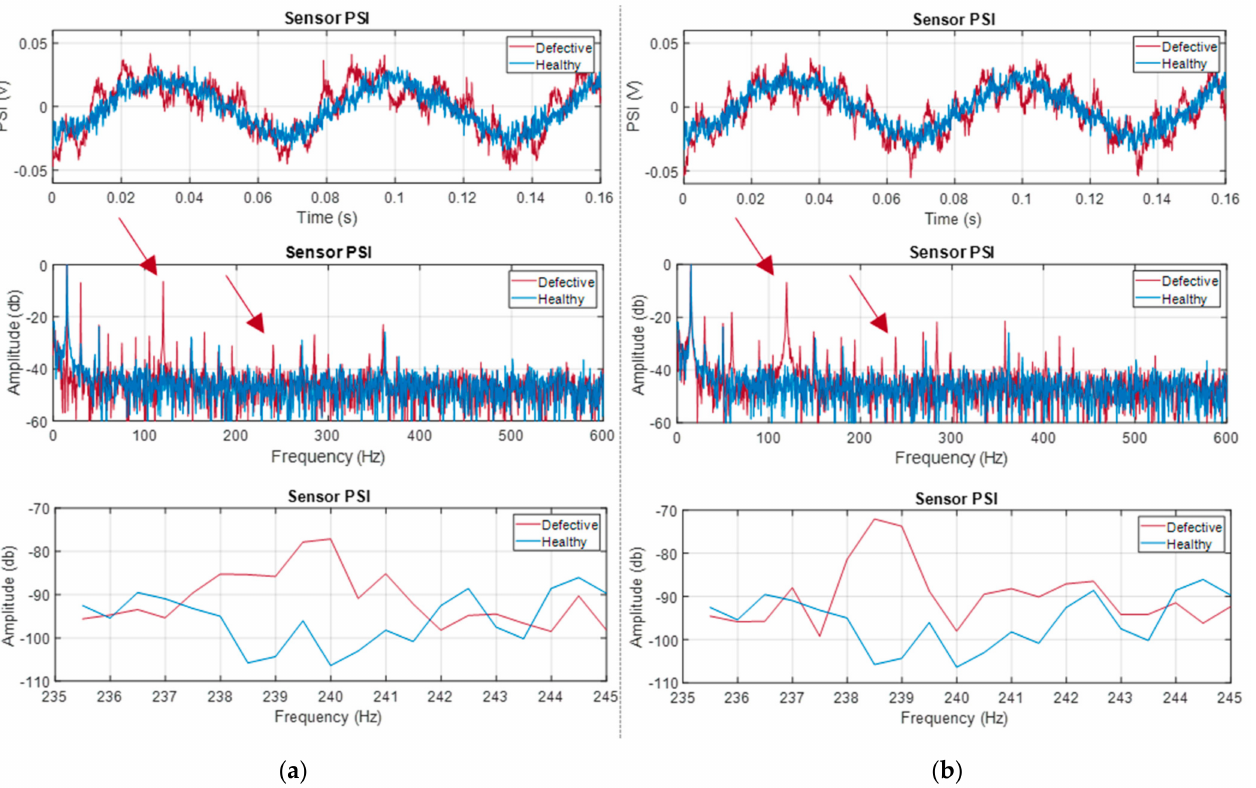
Figure 21. Experimental Investigation of position sensor A breakdown fault at permanent ( a ) high state and ( b ) low state for motor operation at 900 rpm and no-load operation using piezoelectric sensor. From top to bottom: Waveform of piezoelectric sensor PSI output, Frequency spectrum and Narrow frequency spectrum using Goertzel